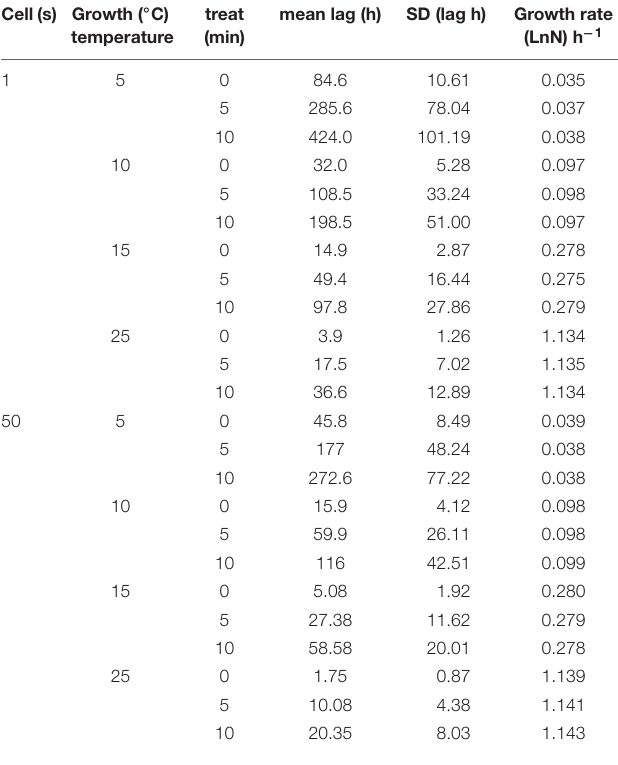
TABLE 2 | Kinetic parameter (lag and umax) of 1 and 50 cells of Cronobacter sakazakii growth of cells able to growth at three different temperatures in tryptic soy broth